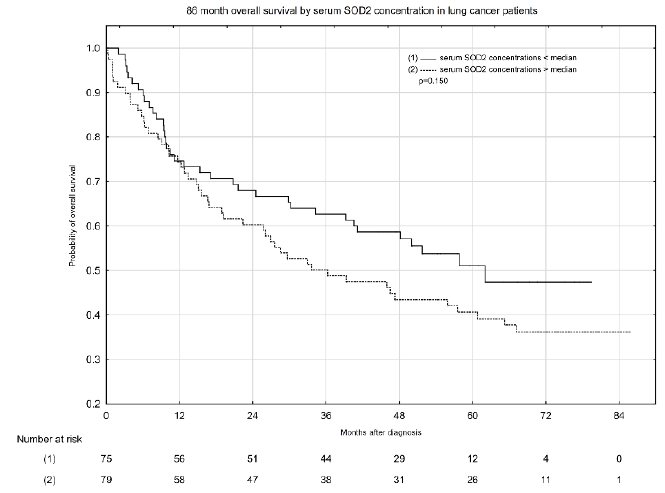
Figure 3. Eighty-six-month overall survival by serum SOD2 concentration in lung cancer patients.